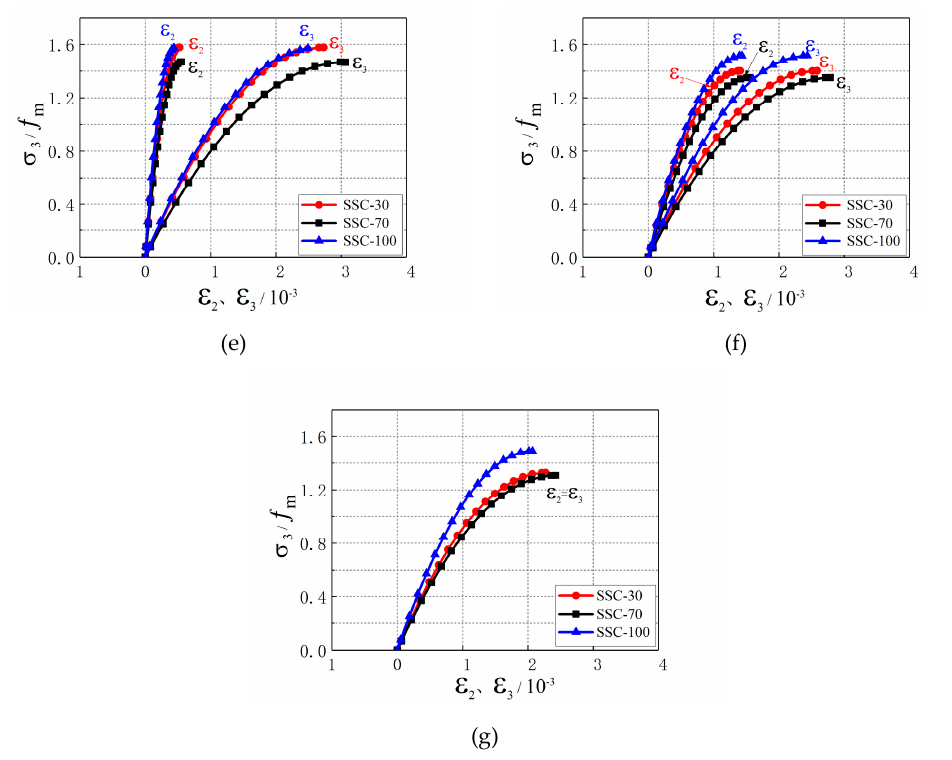
Figure 7. Stress–strain curves of SSC under biaxial compressive stress. ( a ) SSC-30; ( b ) SSC-70; ( c ) SSC-100; ( d ) σ 2 : σ 3 = 0.25; ( e ) σ 2 : σ 3 = 0.50; ( f ) σ 2 : σ 3 = 0.75; ( g ) σ 2 : σ 3 =